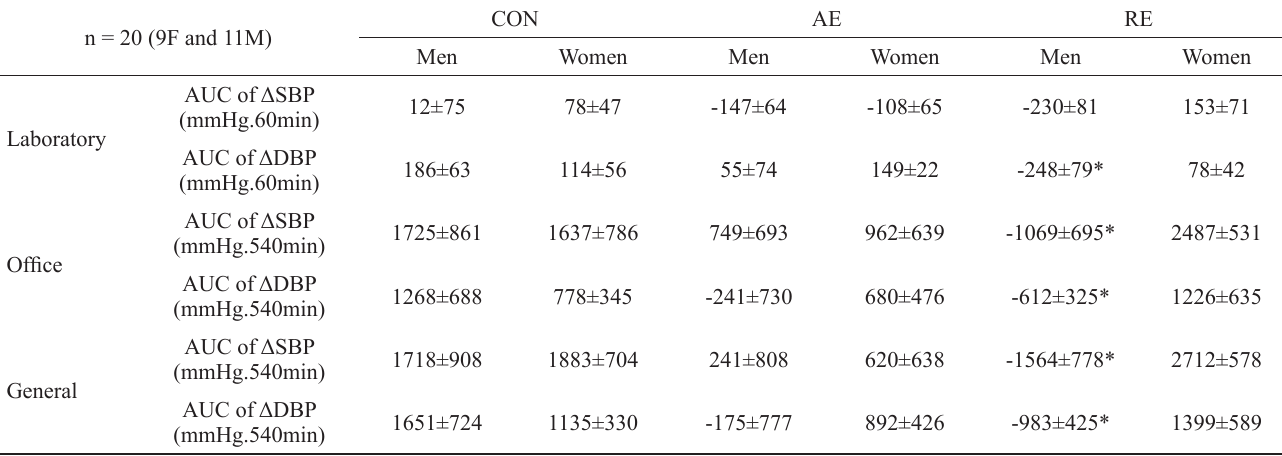
Table 2. Sex difference on Area Under the Curve of BP CON AE RE n = 20 (9F and 11M) Men Women Men Women Men